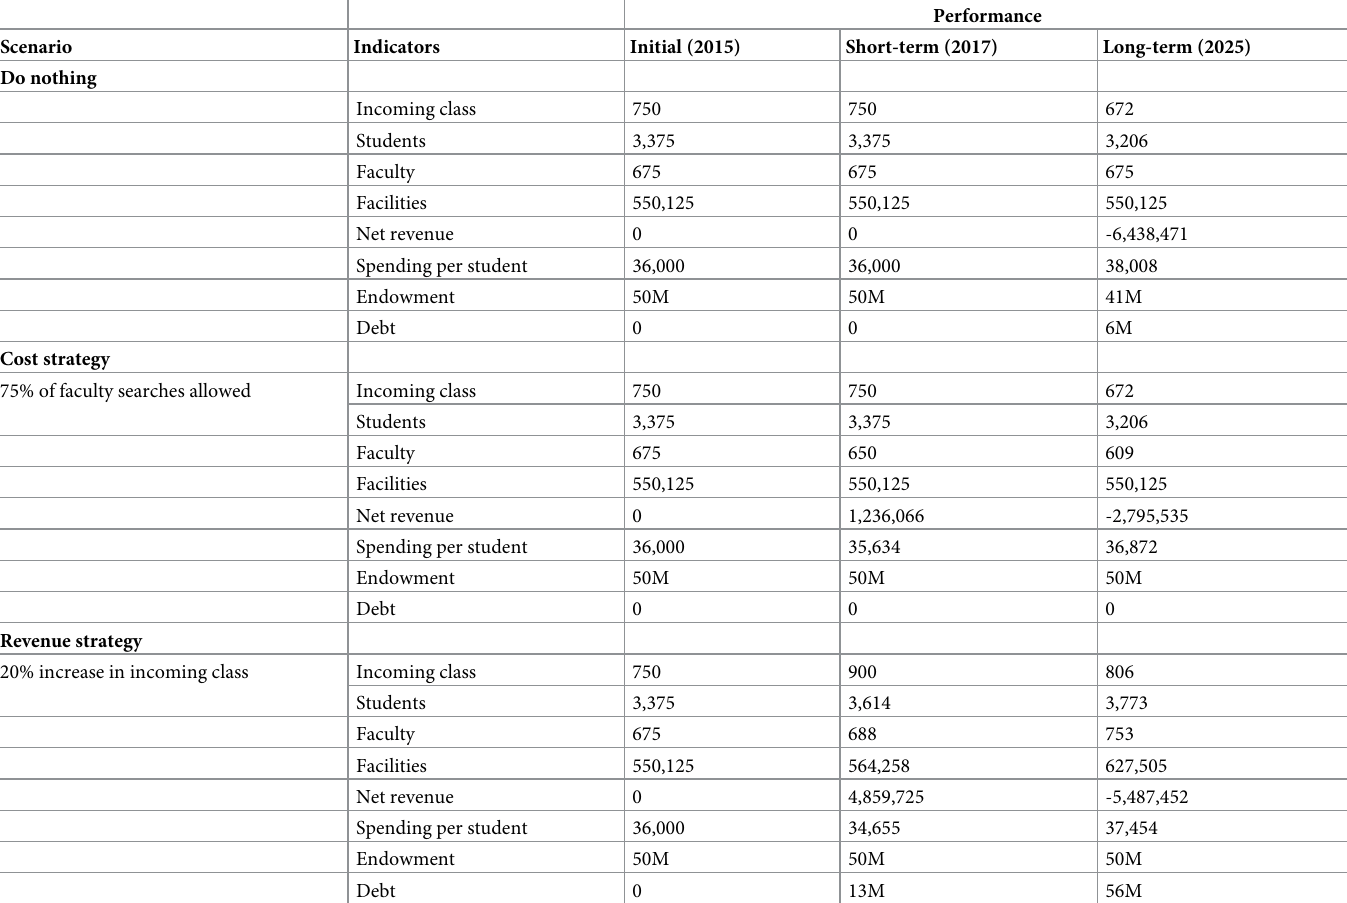
Table 1. College performance in the short (2 years) and long term (10